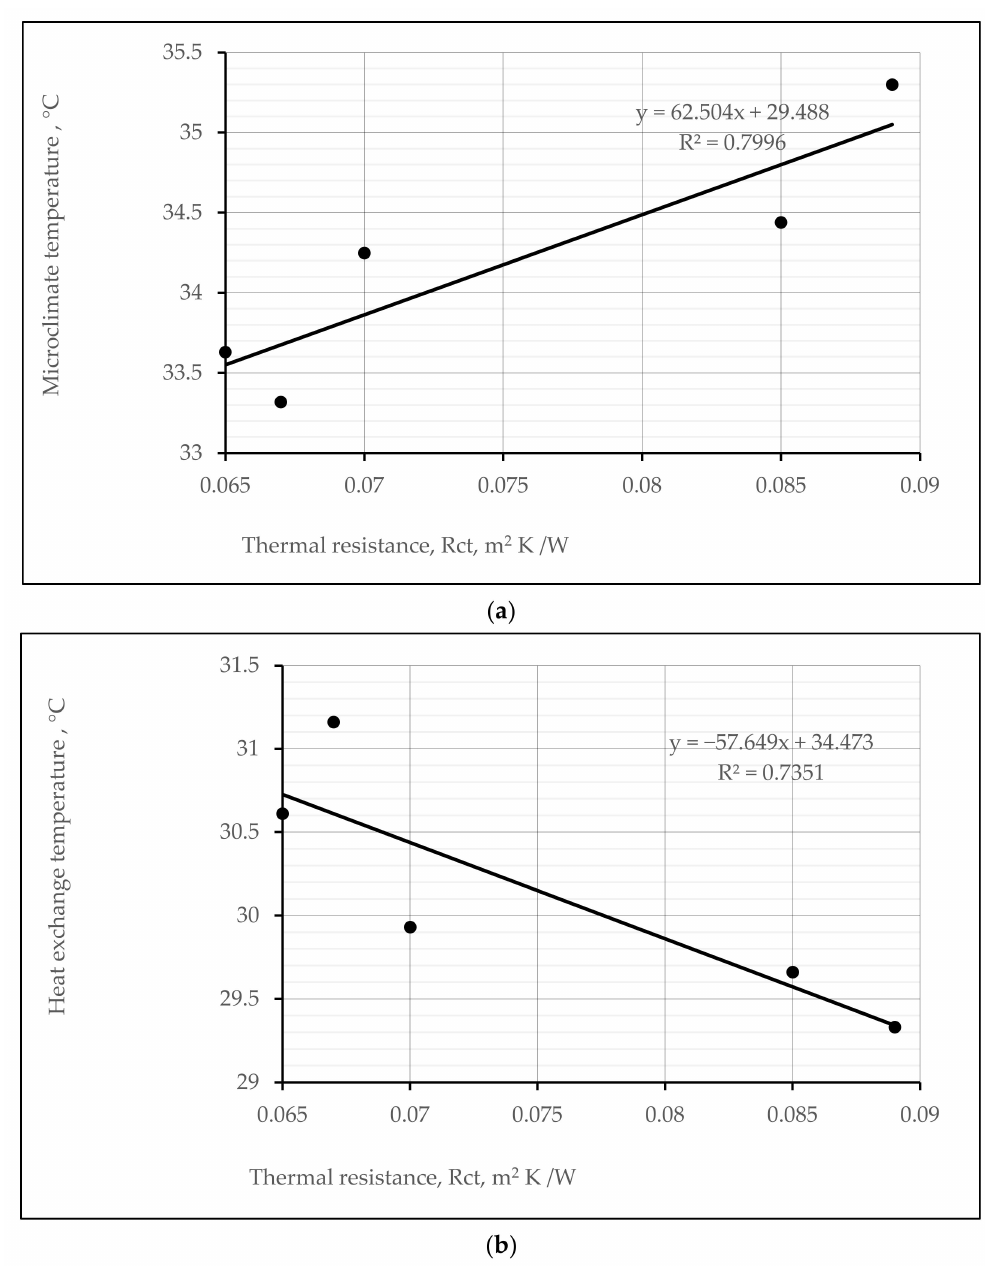
Figure 14. Relationships (at time 300 s) between the microclimate temperature and thermal resistance ( a ), and heat exchange temperature on the outer surface and thermal resistance ( b ) of different structures of